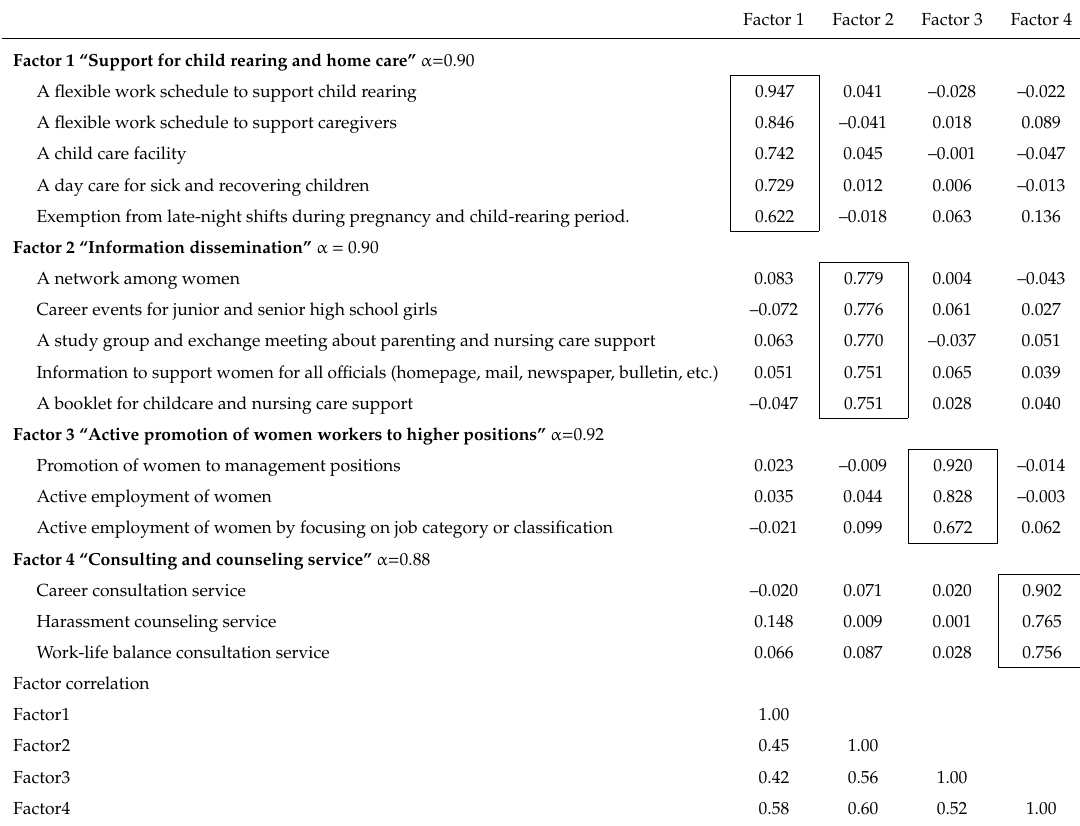
Table 2. Exploratory factor analysis result.